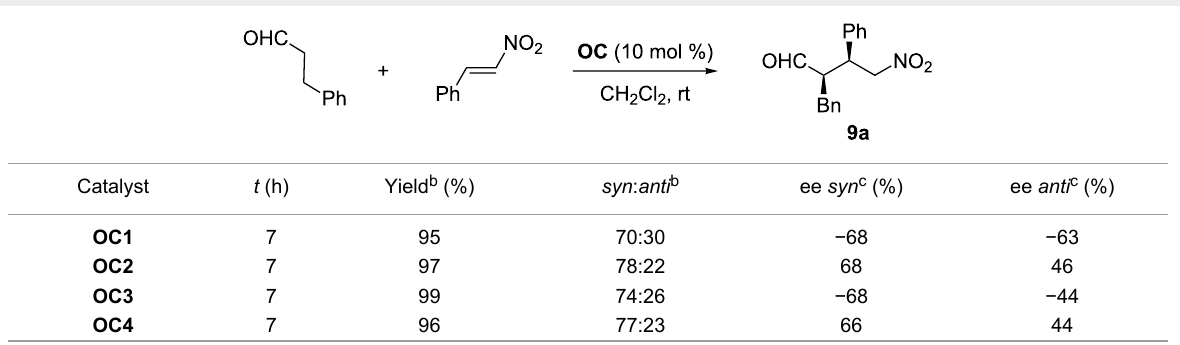
Table 1: Initial screening of catalysts for the Michael addition of 3-phenylpropionaldehyde to trans- β -nitrostyrene. a